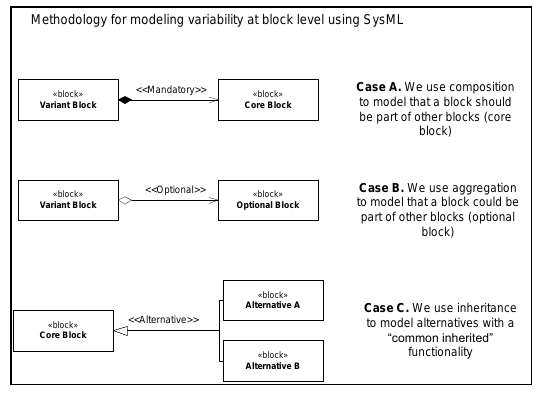
Figure 3. Metamodel for block variability